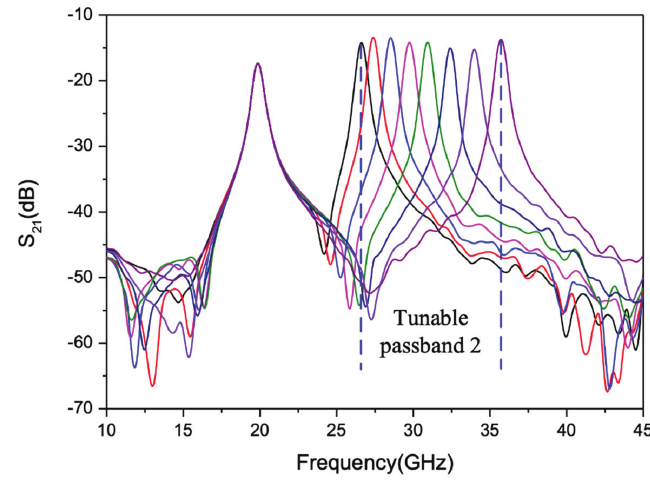
Figure 7. Results of a tunable dual-passband MPF with a high out-of-band suppression ratio.